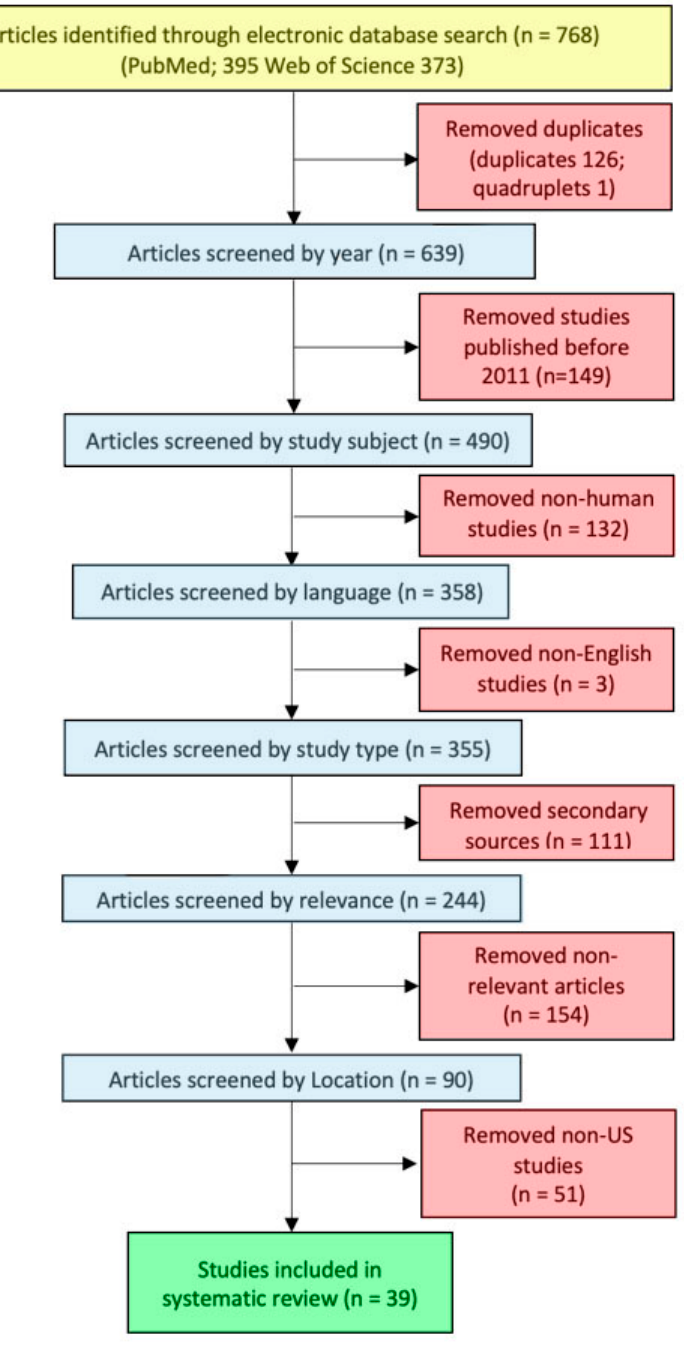
Figure 1. Flowchart of study selection for the systematic review.